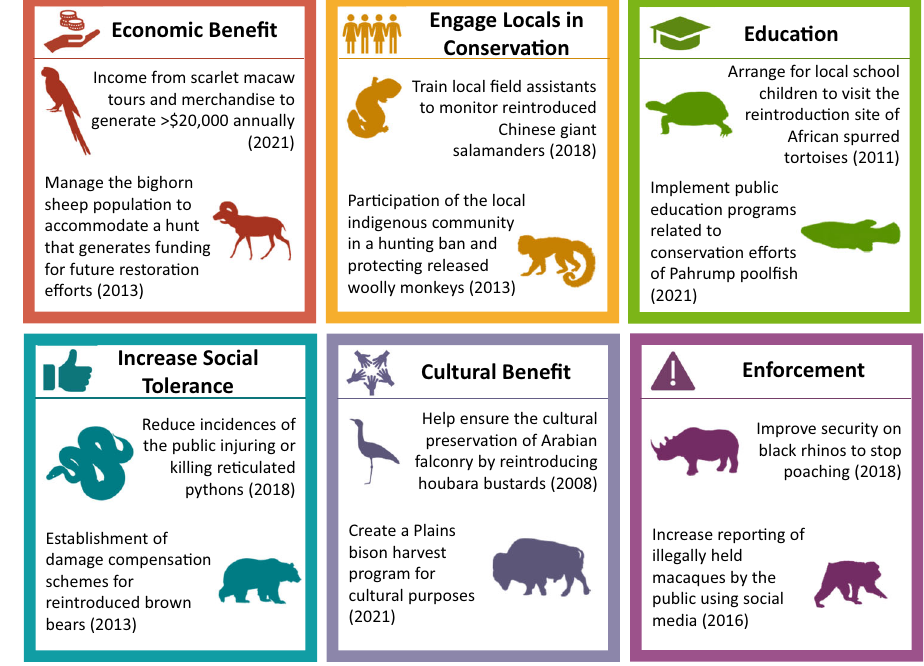
Fig.4|Strategiesusedtoincorporatehumandimensionsinwildlifetranslocation. Strategieswereidenti fi